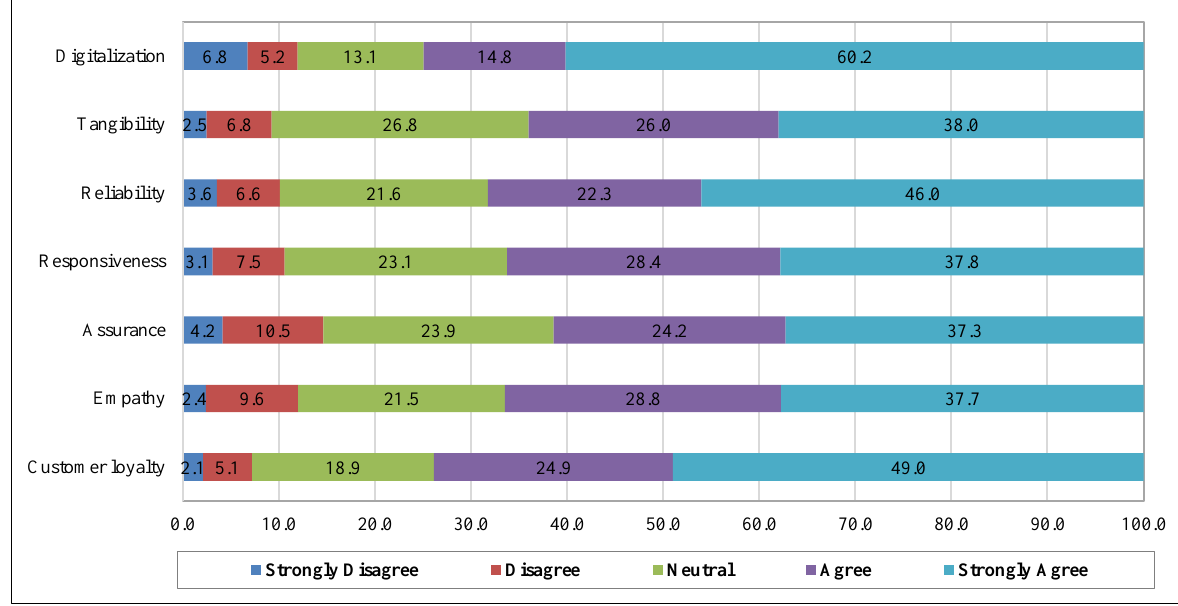
Figure 3. Respondents' degree of compliance